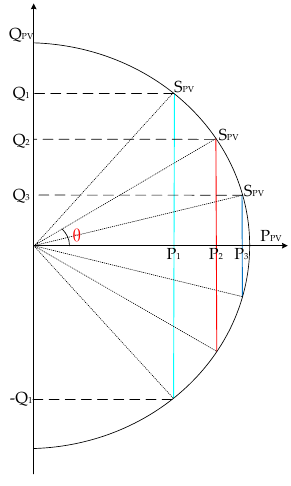
Figure 1. Reactive power output bounds of PV inverter.